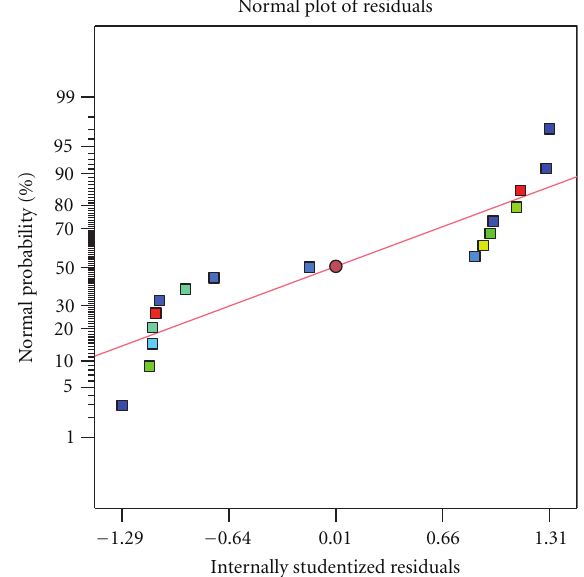
Figure 6: Plot of predicted versus actual values for % BA degradation.